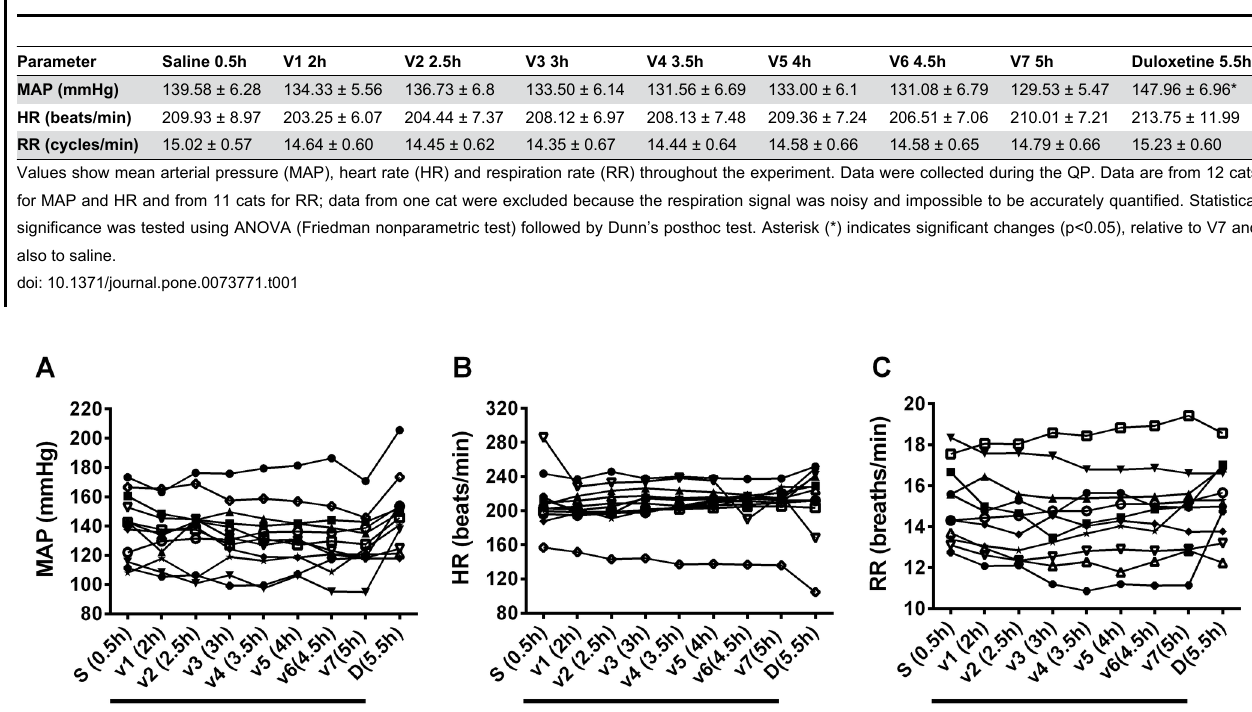
Table 1. Time course of cardiorespiratory parameters.